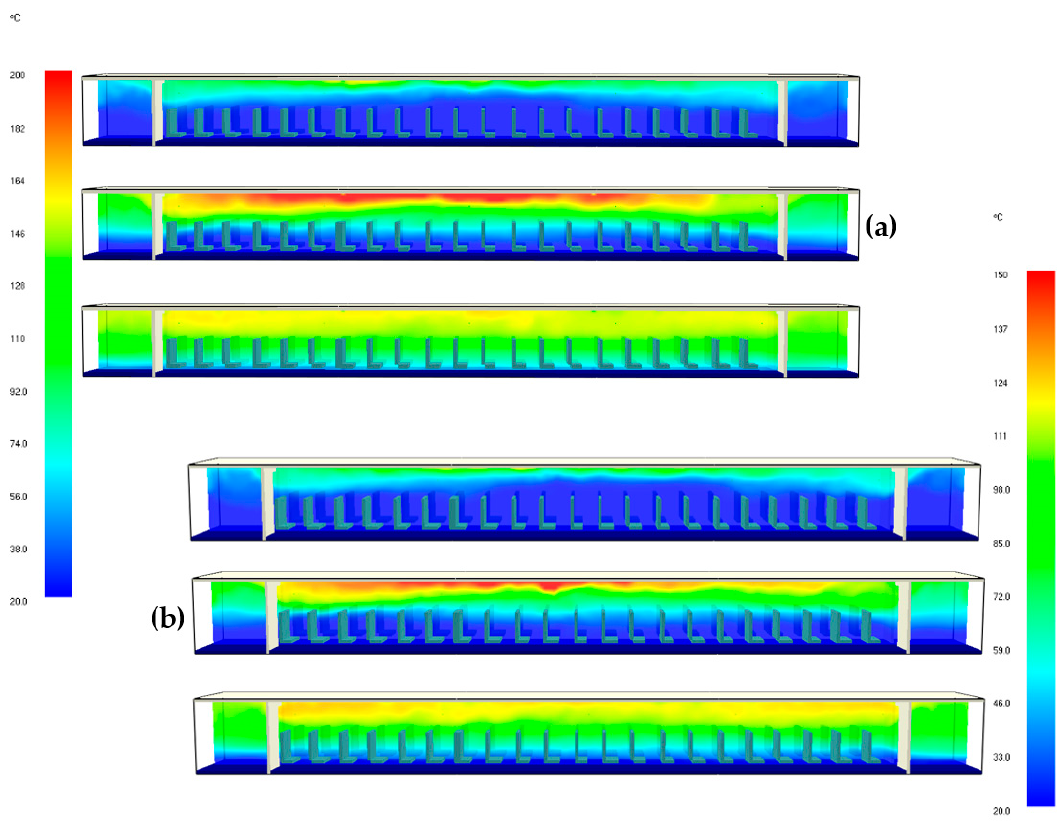
Figure 10. Temperature variations along the central plane of the carriage after 40 s, 80 s and 120 s for ( a ) high ignition model and ( b ) low ignition model.